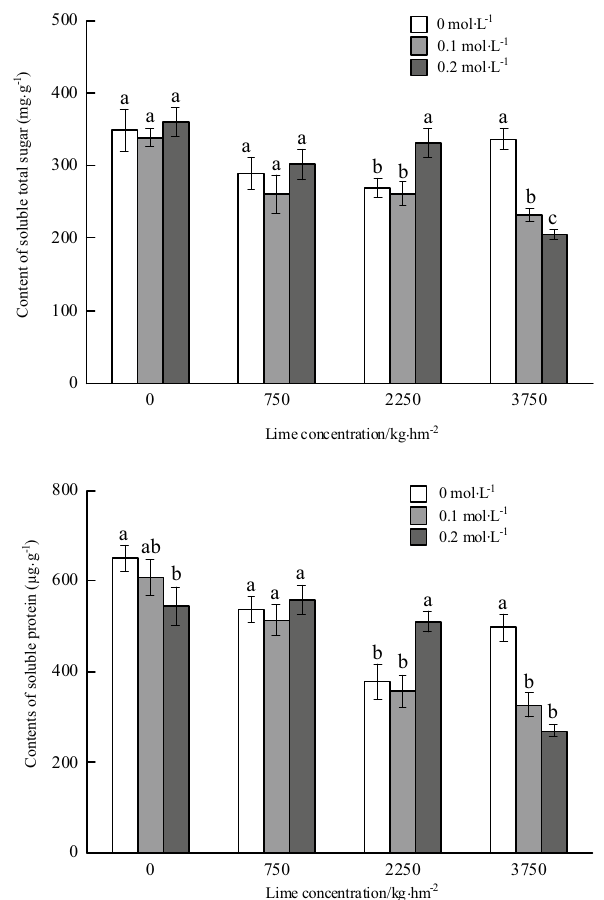
Figure 3. Effects of foliar spraying of oxalic acid on contents of soluble total sugar and soluble protein in the roots of Panax notoginseng under Cd